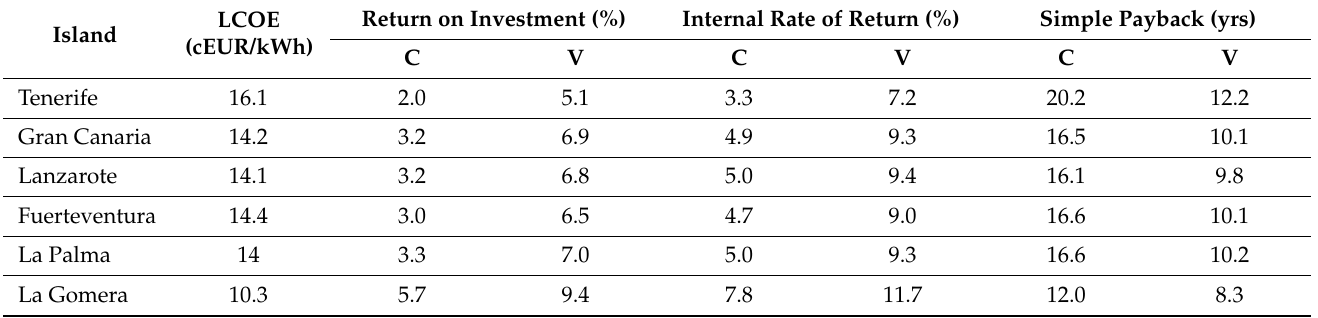
Table 17. Economic analysis summary of the non-interconnected scenario segmented by